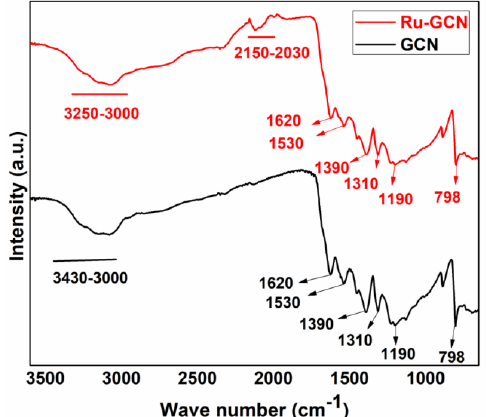
Figure 3. Fourier Transform Infra ‐ red (FTIR) spectra of GCN and Ru ‐ GCN. The elemental composition and morphology of the fabricated Ru ‐ GCN catalyst was performed by scanning transmission electron microscopy (STEM) and transmission electron microscopy (TEM). From Figure 4, it is observable that the Ru particles are dis ‐ tributed everywhere on the surface of graphitic carbon nitride nanosheets. The average size of the Ru nanoparticles on the GCN surface has been found to be around 1–2 nm and